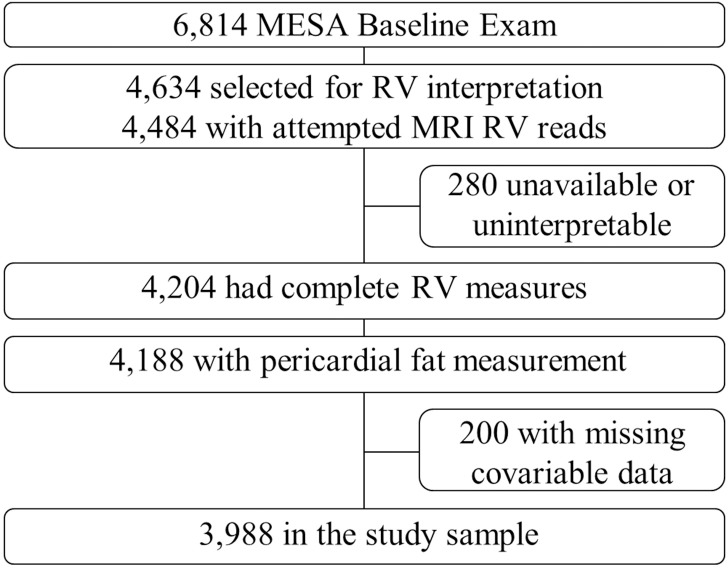
Study sample.MESA = Multi- Ethnic Study of Atherosclerosis; MRI = magnetic resonance imaging; RV = right ventricle.